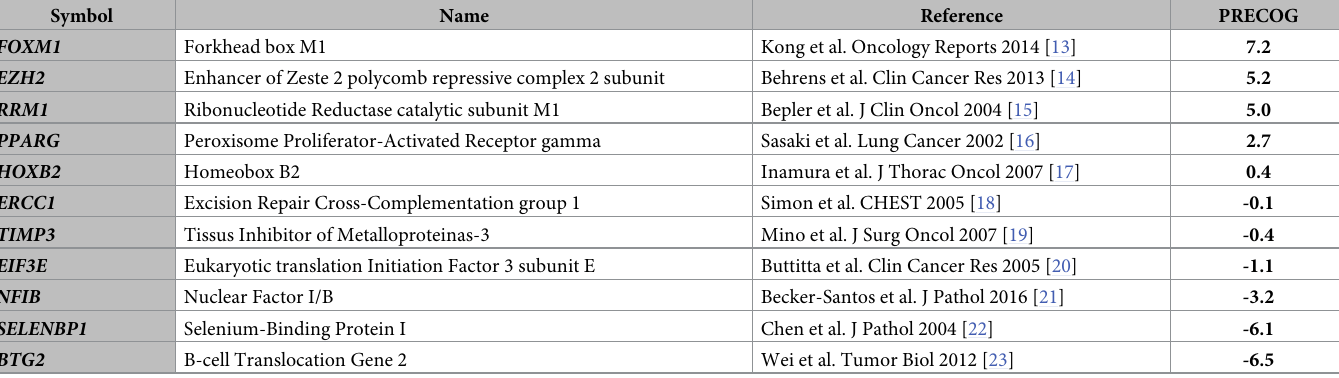
Table 2. Investigation of selected prognostic tumor-based gene expression biomarkers in